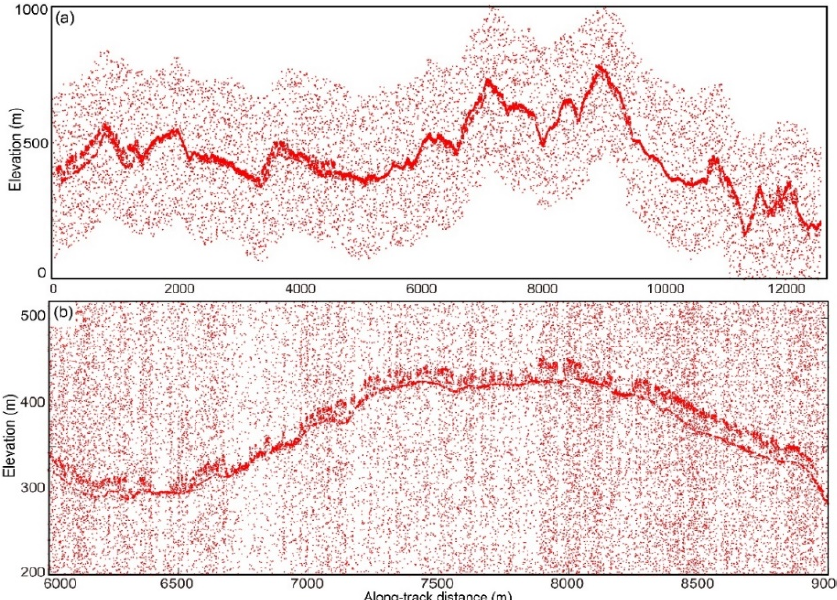
Figure 1. ( a ) Original photons of test site A. ( b ) Original photons of test site B.